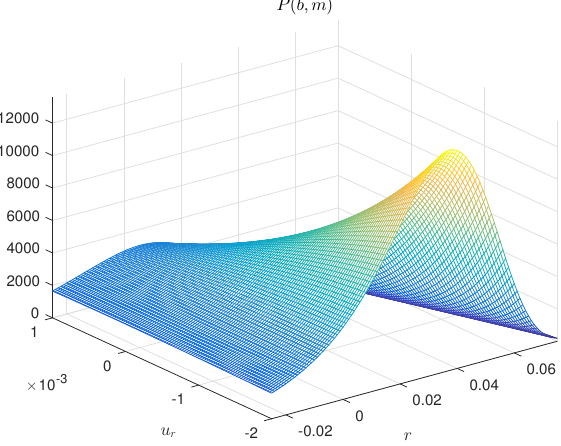
Figure 1. The joint PDF of the random parameters r and u r for the range J = I r (cid:83) I u